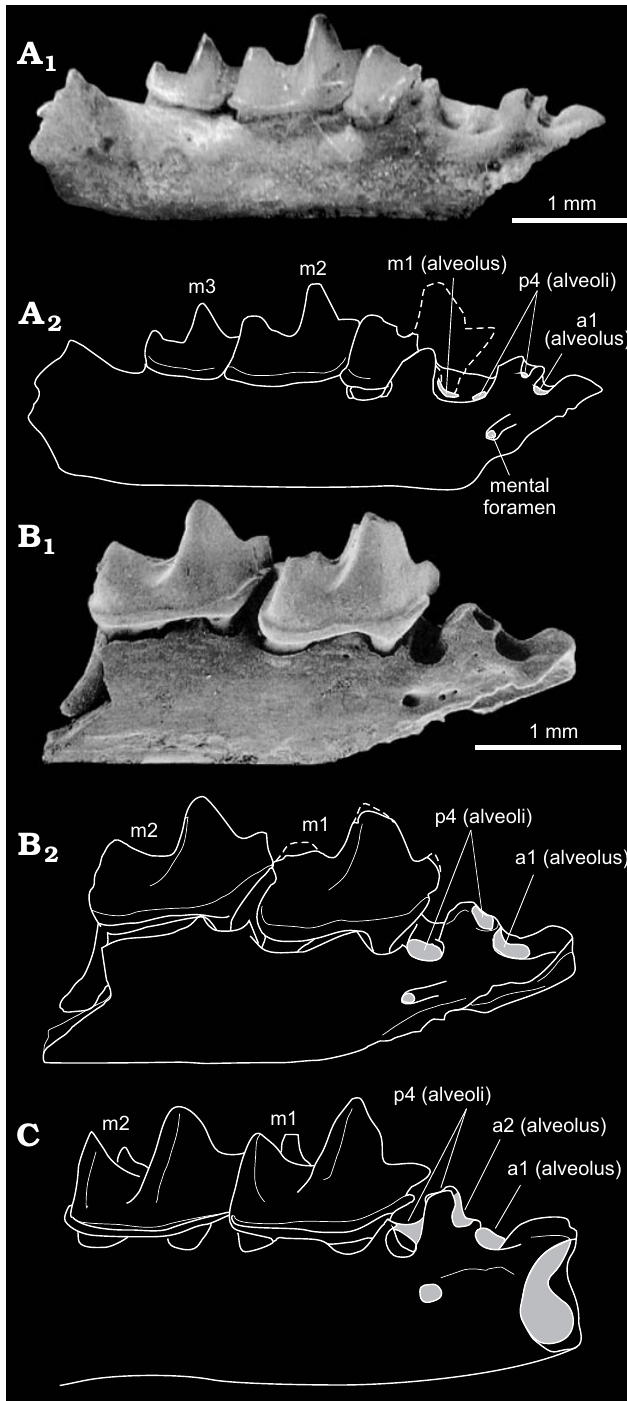
Fig. 8. Comparison of the alveoli of crocidosoricine shrews Miosorex pusil- liformis (Doben-Florin, 1964) (A, B), and Miosorex desnoyersianus (Lartet, 1851) (C). A . BSP 10607 (paratype) from Wintershof-West, Germany, MN3, early Miocene; right dentary fragment (from Doben-Florin 1964: 89, pl. 3: 1a). B . SMNS#44716_B3 from Stubersheim 3, Germany, MN3–4, early Miocene; right dentary fragment (from Ziegler 1989: 67, pl. 3: 7b). C . FSL 66225 from Sansan, France, MN6, middle Miocene; right dentary fragment (from Engesser 2009: 21, fig. 11C). Dashed line, reconstructed anterior half of m1; grey areas, alveoli and foramina opening. Optical pho- tograph (A 1 ), SEM photograph (B 1 ), explanatory drawings (A 2 , B 2 ,